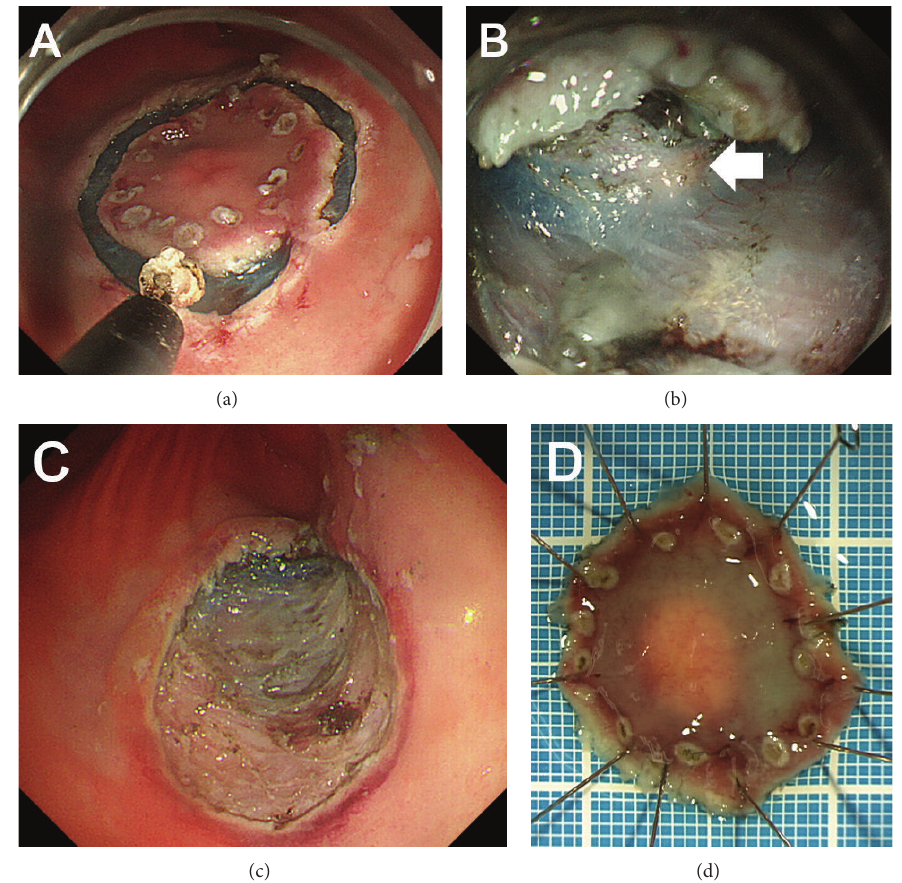
Figure 2: Images during the endoscopic submucosal dissection (ESD). After marking, a circumferential incision is made around the lesion